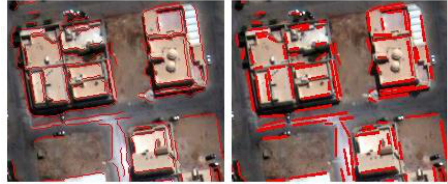
Figure 7. Sample of straight line detection: (left) edge detection using the Canny algorithm and PCA; (right) straight lines after line simplification